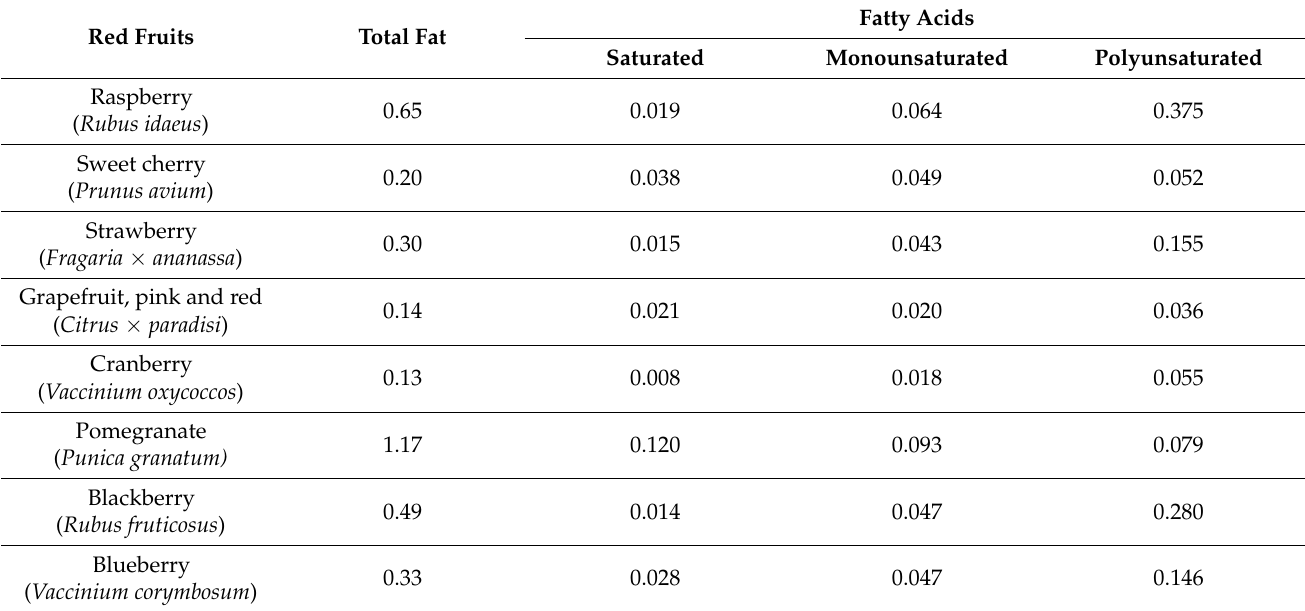
Table 5. Total fat and fatty acids (g/100 g FW) composition of different red fruits in the raw form. Adapted from